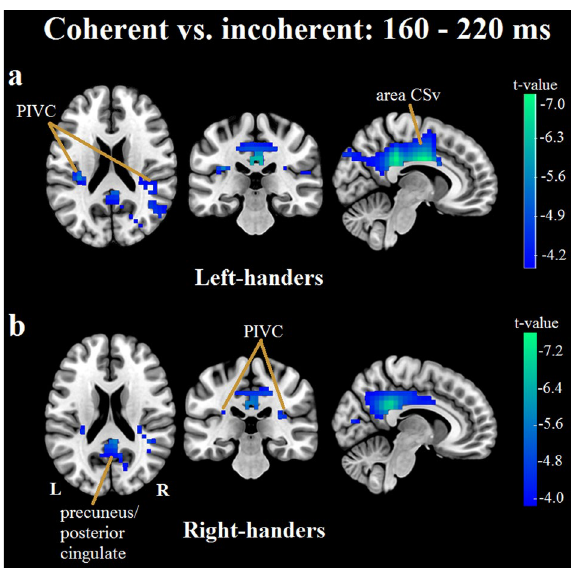
Figure 3. Visualisation of results from source localization analyses contrasting the estimated generators in the coherent versus the incoherent condition in the early (160–220 ms) window. In both left- and right-handers, estimated source activity differed across a large network consisting of the cingulate (including the cingulate sulcus visual (CSv) area), retrosplenial cortex, precuneus, sensorimotor, visual, parieto-occipital, frontal, and posterior insular/PIVC regions. Estimated source activity modulations in the cingulate, precuneus, and posterior insular/PIVC regions are depicted for left-handers ( a ) and right-handers ( b ). While left-handers exhibited bilateral activity in posterior insular/PIVC regions, right-handers showed a modest hemispheric asymmetry with more activity in the right posterior insular/PIVC regions (see Supplementary Fig. S2 for detailed visualization).